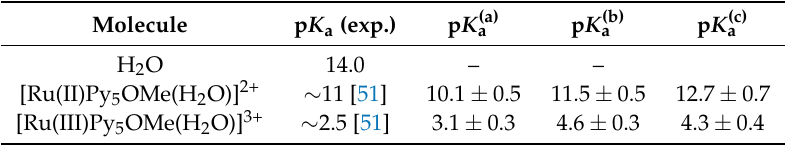
Table 3. All results presented here are calculated at 320 K, for a cubic box with a side length of 19.7340 Å and a cutoff R C = 1.24 Å over a trajectory of 10–15 ps (where the first 5 ps were not